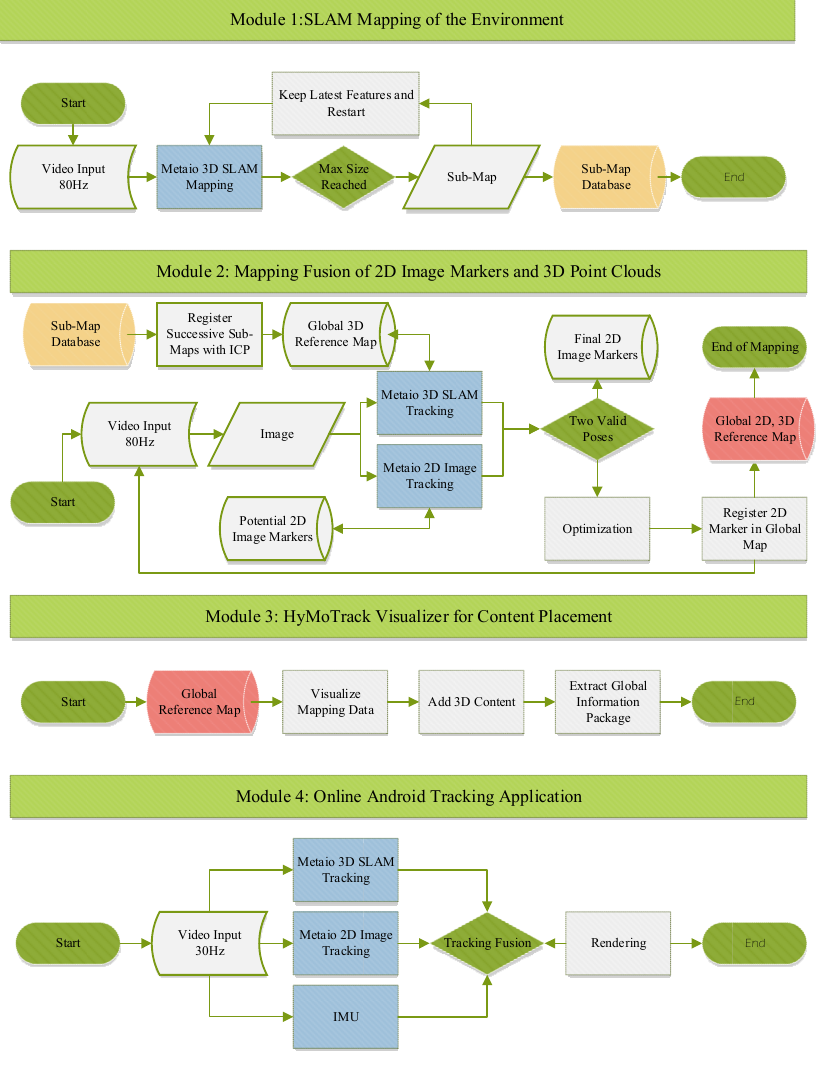
Figure 2. System workflow of the presented indoor tracking solution.